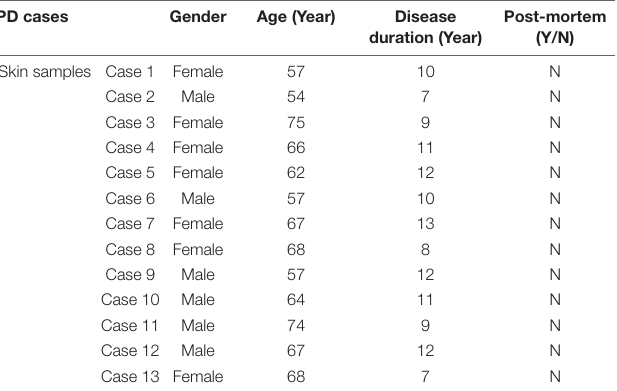
TABLE 1 | Clinical and demographic data of the recruited patients with